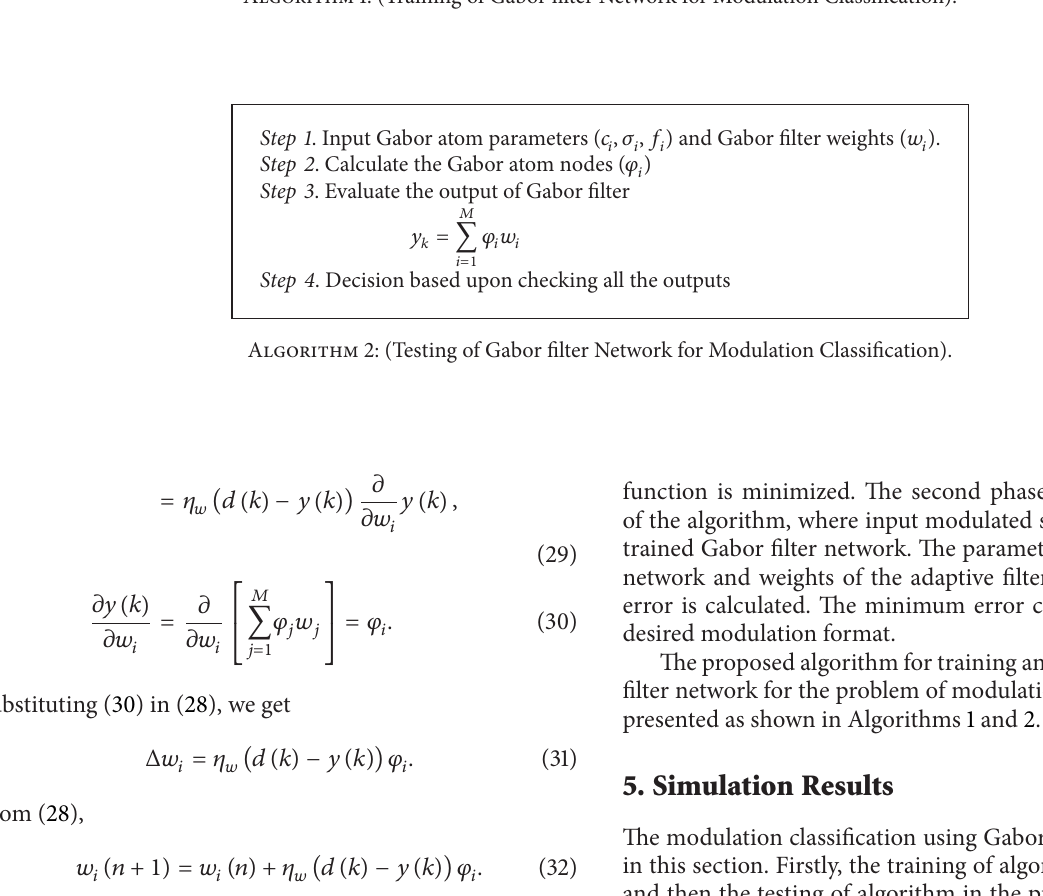
Algorithm 1: (Training of Gabor filter Network for Modulation Classification).